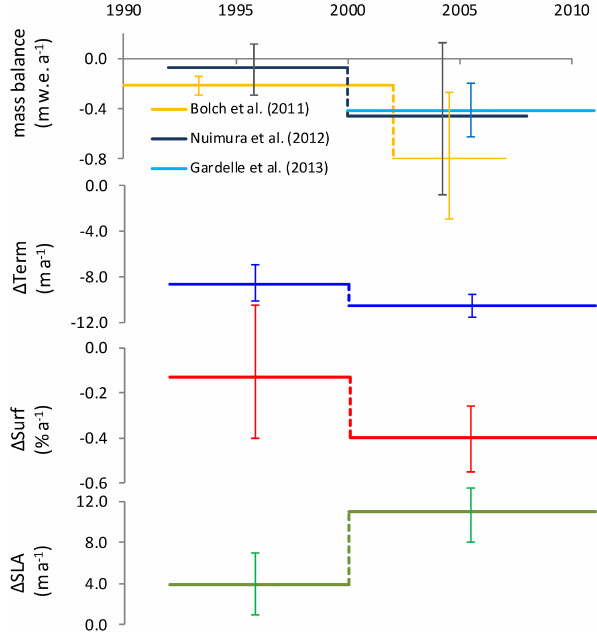
Figure 4. Comparison for 10 selected glaciers using the terminus position change ( 1 Term), glacier surface area loss ( 1 Surf), and shift of snow-line altitude ( 1 SLA) calculated in this study and relevant mass downwasting observations of Bolch et al. (2011), Nuimura et al. (2012). Furthermore, the mass balance data of Gardelle et al. (2013) are